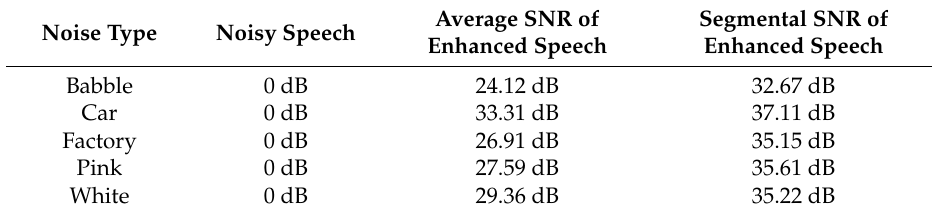
Table 1. Average values of SNR and segmental SNR of noisy speech (0 dB) and enhanced speech.